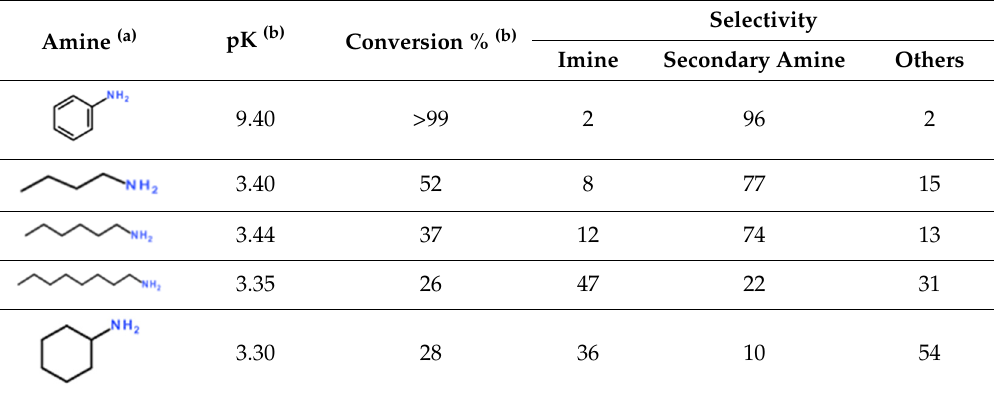
Table 3. Activity and selectivity of 1% Au SI /NiO for the reductive amination of benzyl alcohol with different amines.